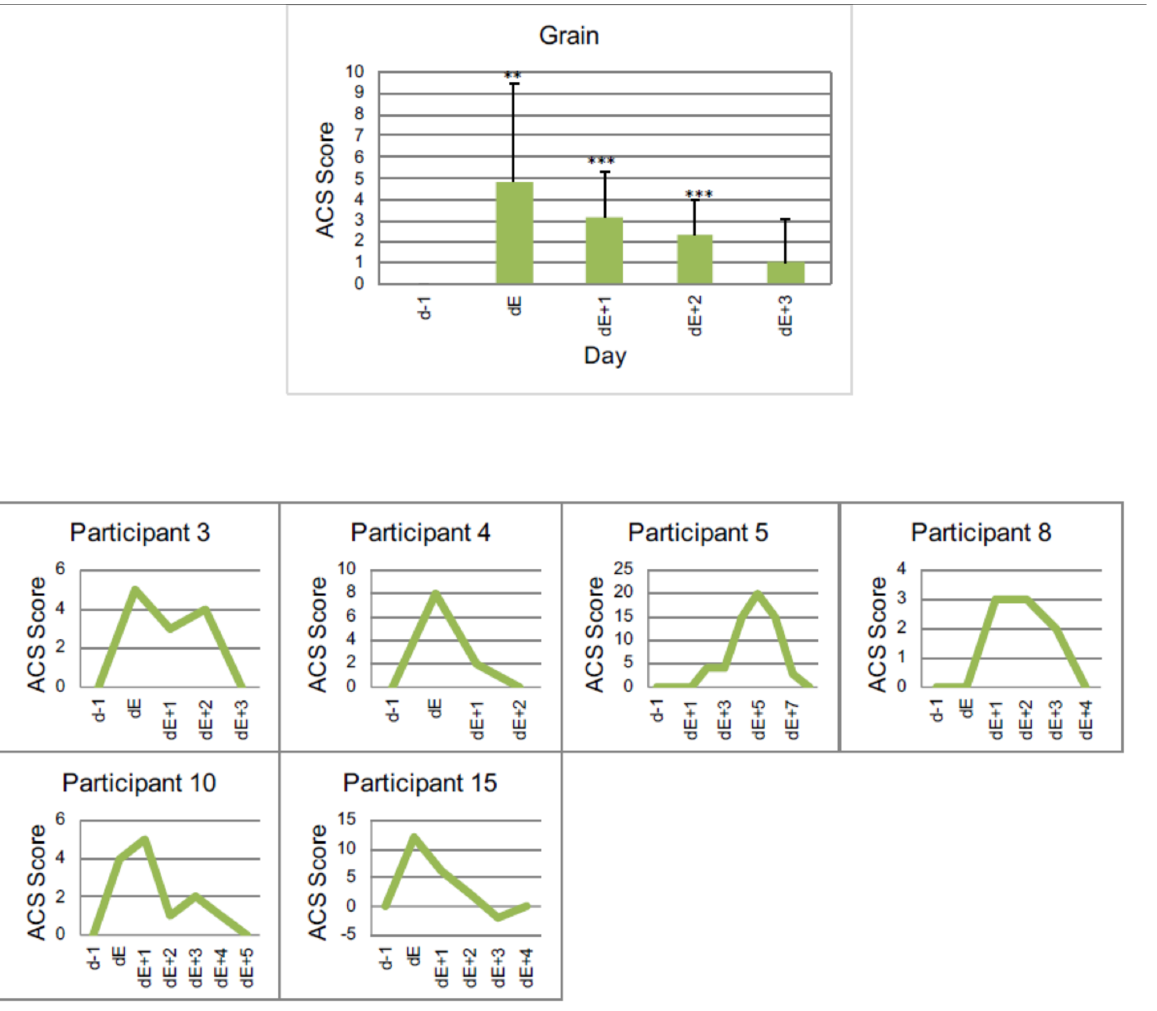
Figure 6. Individual reactions of participants to grain (including oats, wheat and other grain containing gluten) measured by ACS, p < 0.01 **, p < 0.001 *** (one-sided t -test). dE − 1: day before reintroduction, dE: day of reintroduction, dE + 1: day 1 after reintroduction etc.